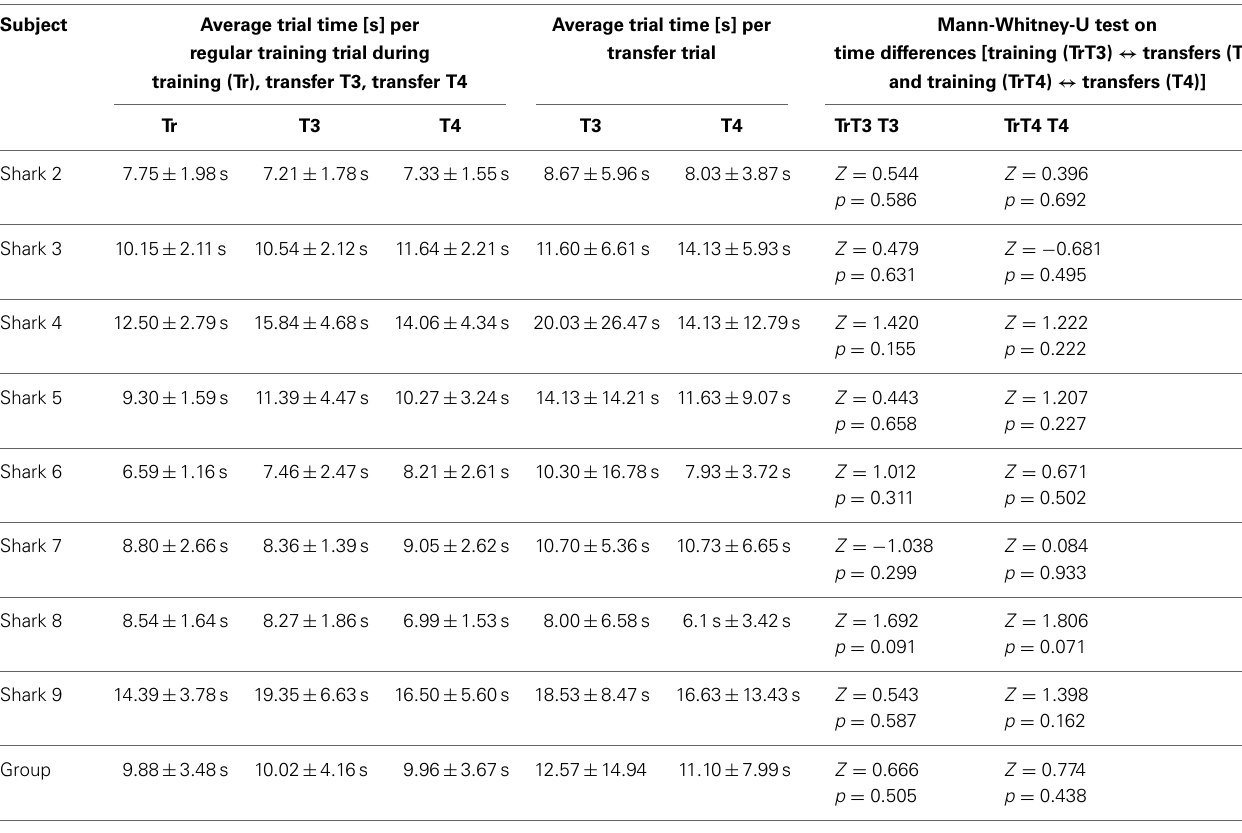
Table 2 | Part 2: Statistics on the average trial time [s] during regular training trials and transfer tests during Experiment 2: subjective contours.